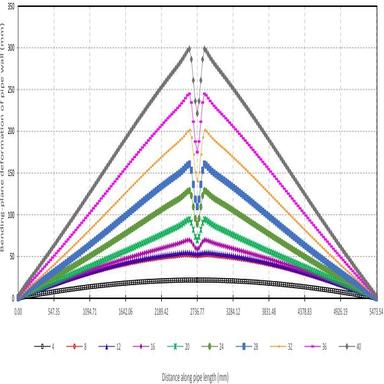
Evolution of wrinkle deformation for half-length pipe model.